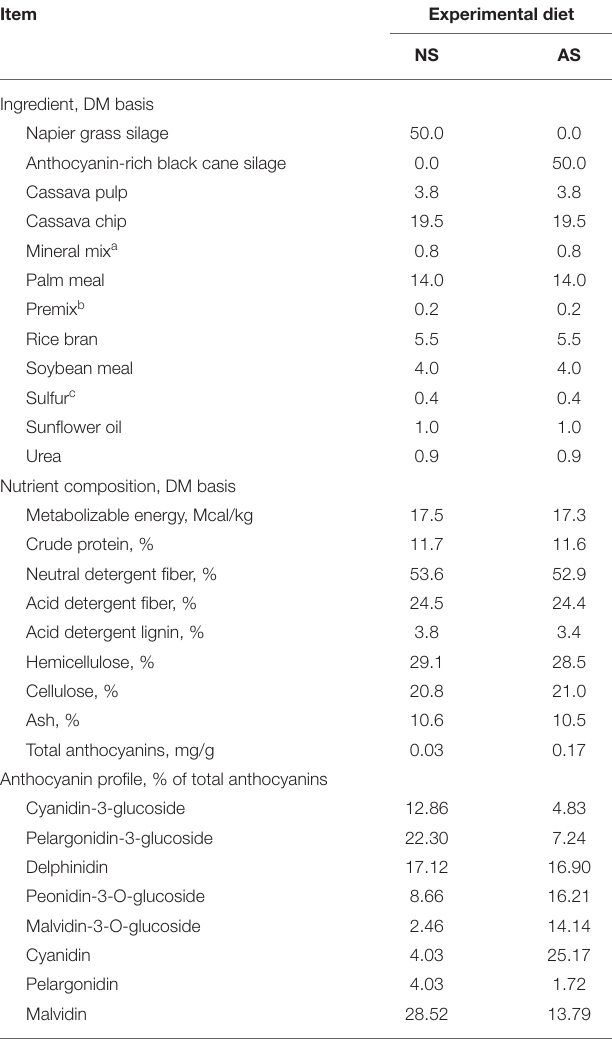
TABLE 1 | Ingredients and nutrient composition of Napier grass silage (NS) and anthocyanin-rich black cane